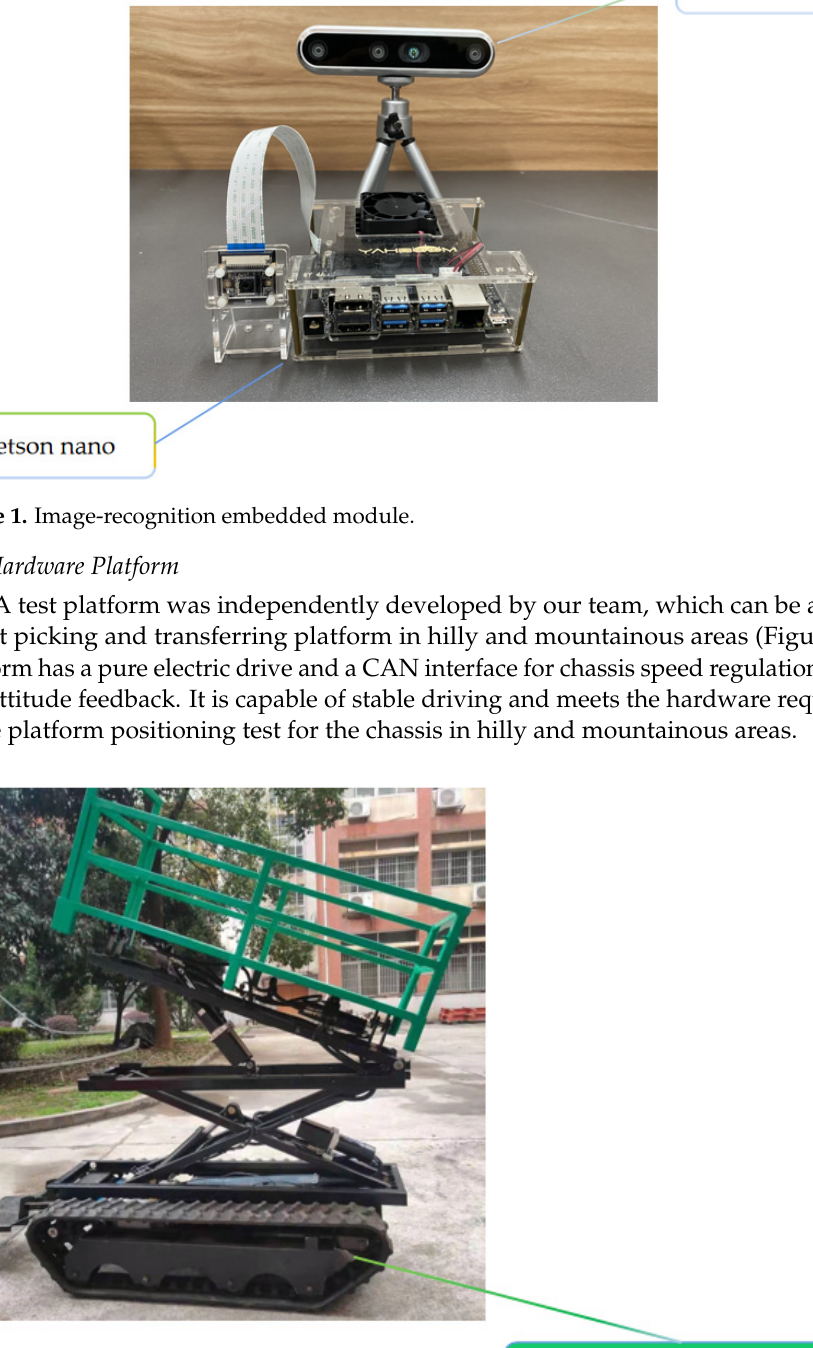
Table 1. Training parameter settings.